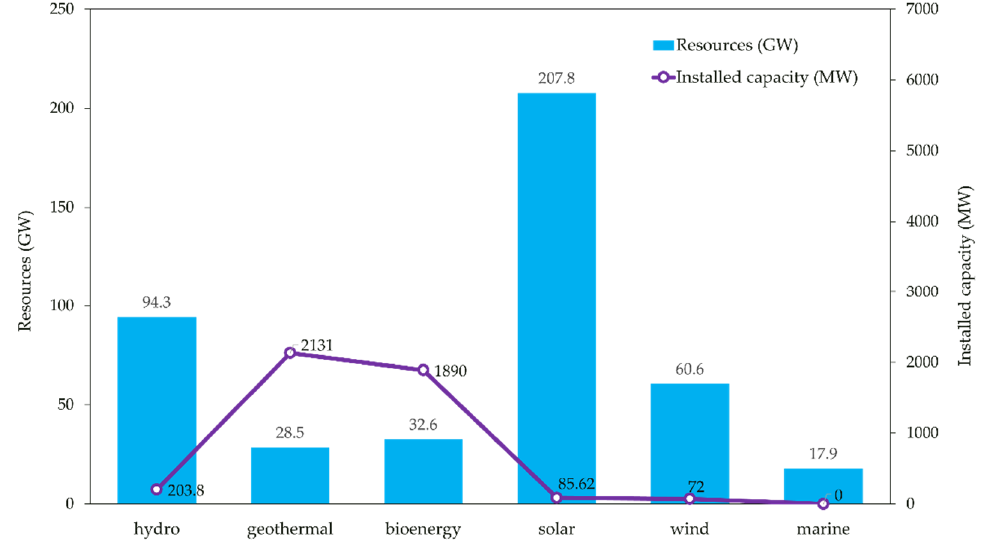
Figure 1. Estimated total resource (GW) and installed extraction capacity (MW) of various renewa- and installed capacity ble energy sources in Indonesia (adapted from [3,4]). Note the difference in scaling between resource and installed capacity figures.